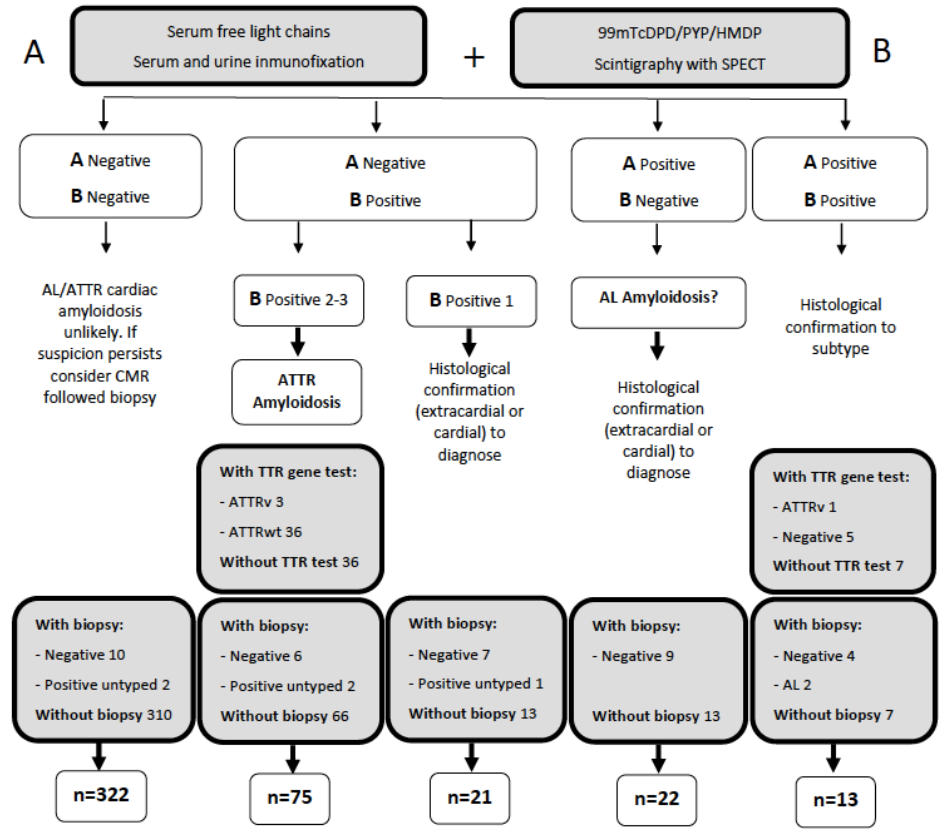
Figure 1. Diagnostic algorithm for cardiac amyloidosis.